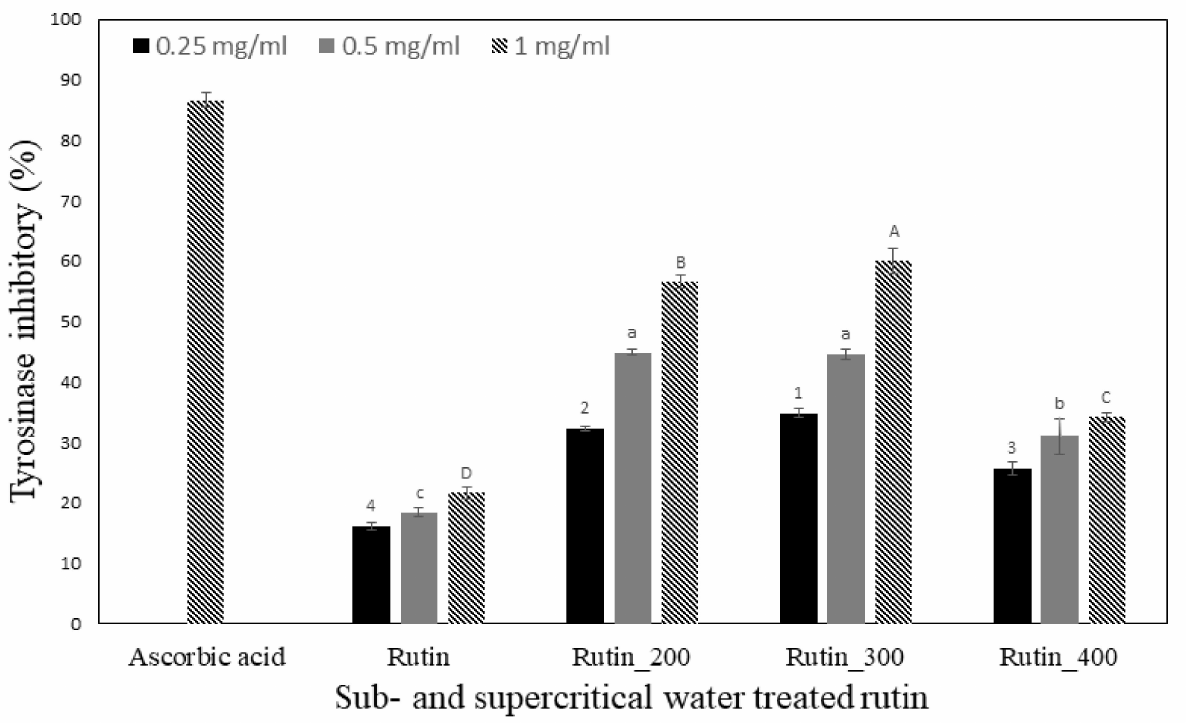
Figure 2. Tyrosinase inhibitory activity of rutin treated by different pressure and temperature. Data are expressed as mean ± SD. Different letters and numbers in the same items indicate a significant difference among different samples by Duncan’s range test ( p <